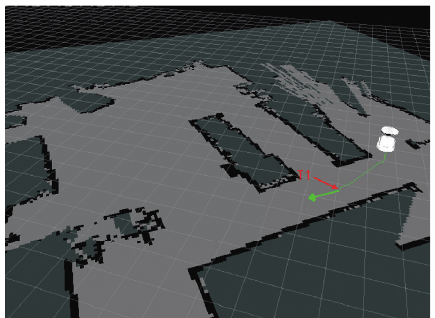
Figure 6: Path-planning response of T1 in RSP-AHEP.